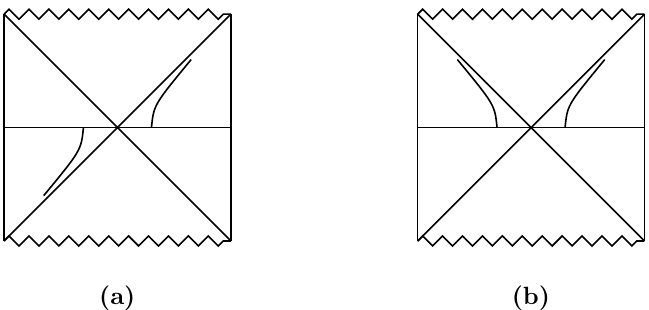
Figure 8. Left: a static bubble nucleated around a single AdS eternal black hole. The Left Exterior and left bubble evolves downward and are unphysical. Right: two bubbles nucleated around two physical black holes. Or one can say that, one bubble is nucleated around the event horizons of a